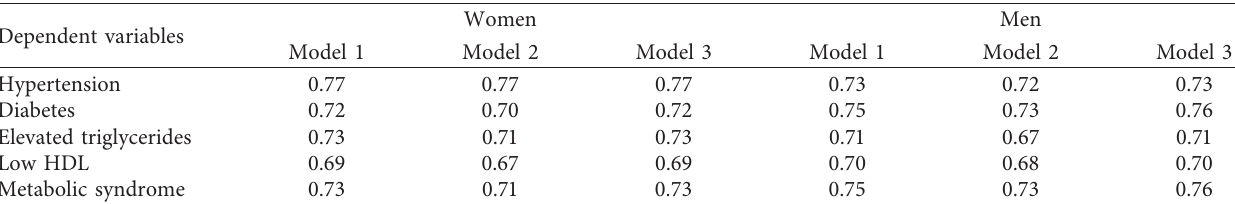
Table 3: AUC from different age-adjusted models with VAT (g), VAT (%), or VAT (index) in prediction of metabolic syndrome and single metabolic components: the Tromsø Study 2015–2016.